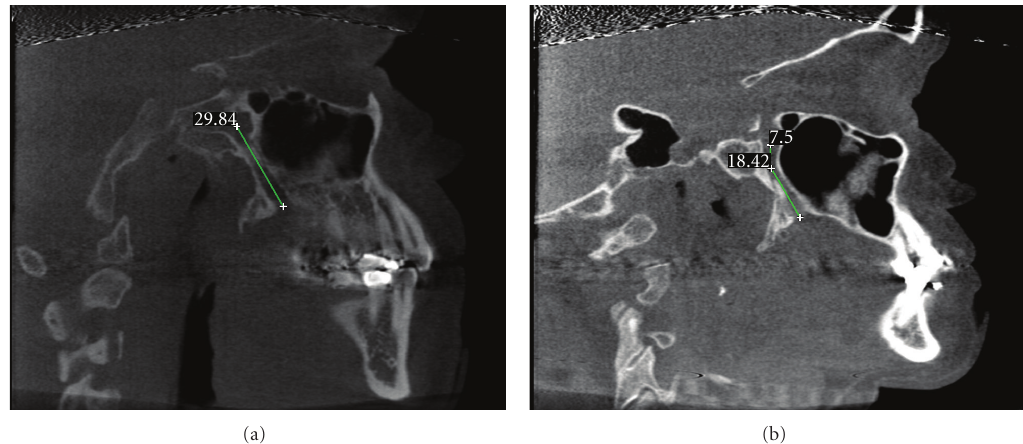
Figure 3: The unilateral sagittal images above, from two di ff erent subjects, were selected as examples of the most common canal pathways in the anterior-posterior plane. Most common sagittal canal pathways as demonstrated in the images are (a) canal travels anterior-inferior and (b) canal travels directly inferior for a distance then anterior-inferior for the remainder.